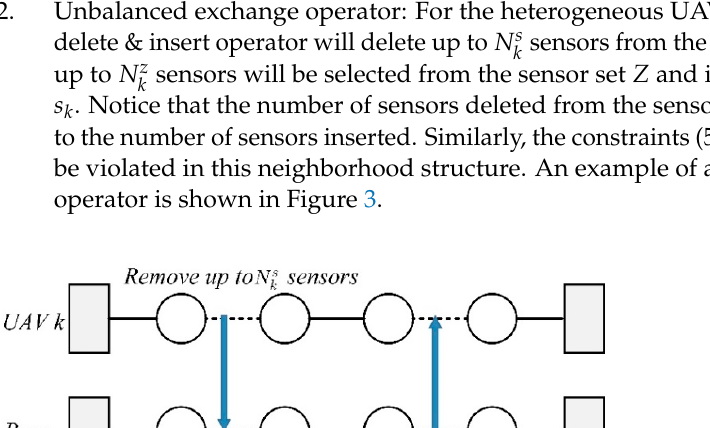
Figure 3. An example of an unbalanced exchange operator. Table 1. The shaking neighborhood structures.